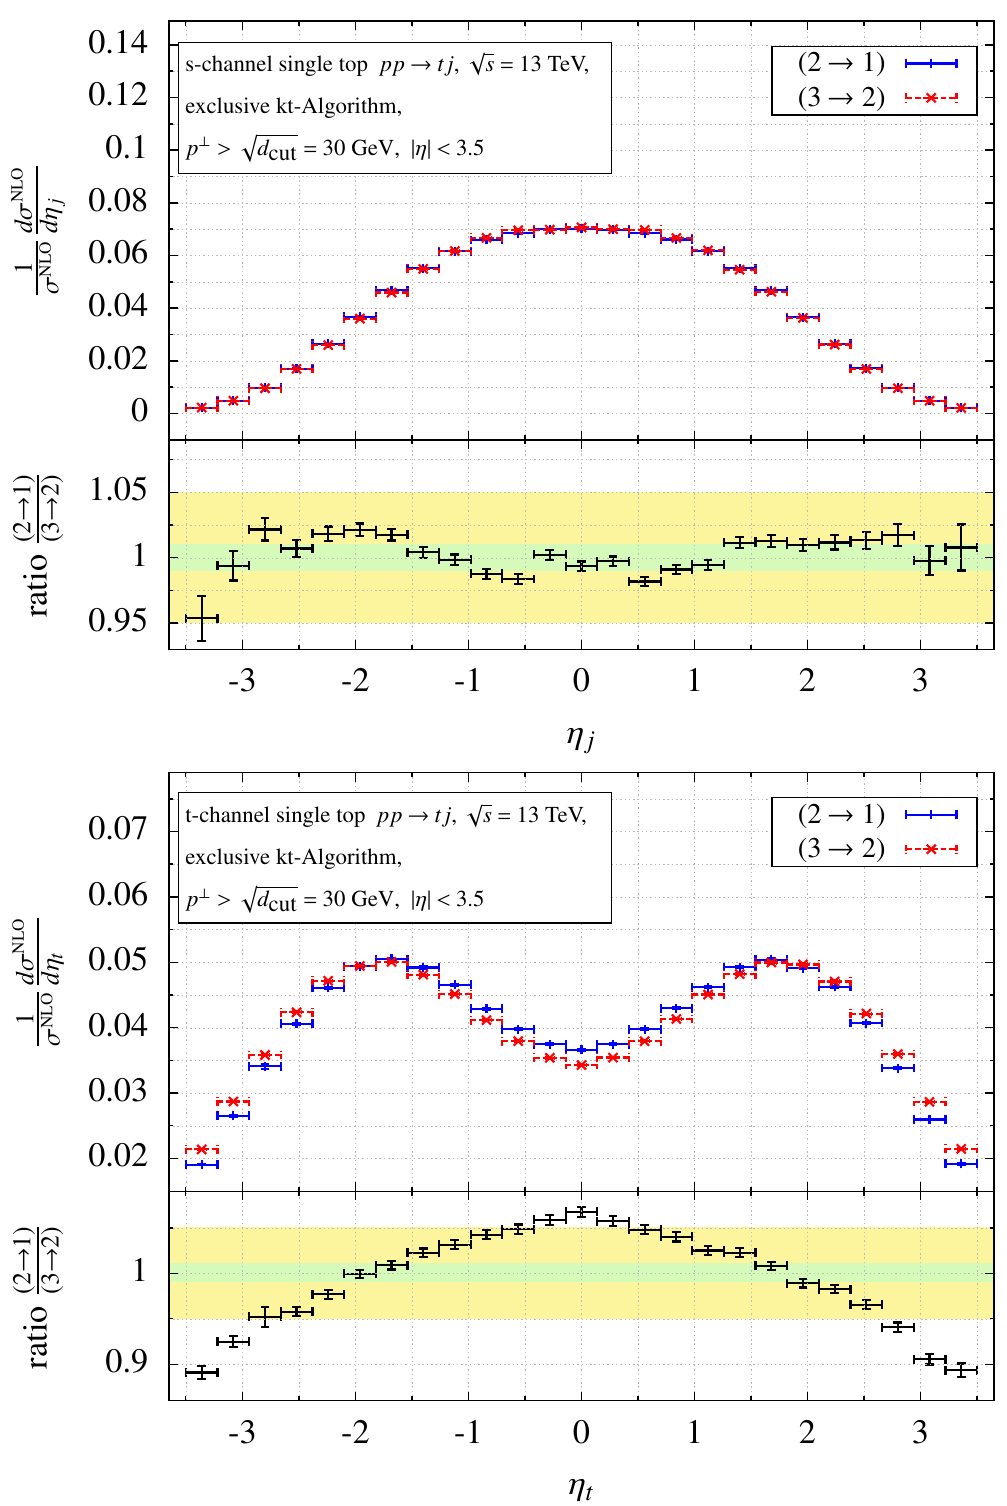
Figure 24 . Pseudo rapidity distributions for the top-tagged and light jet from s - and t -channel single top-quark production at NLO with 3 ! 2 (red, dashed) and 2 ! 1 (blue, solid) jet clusterings.